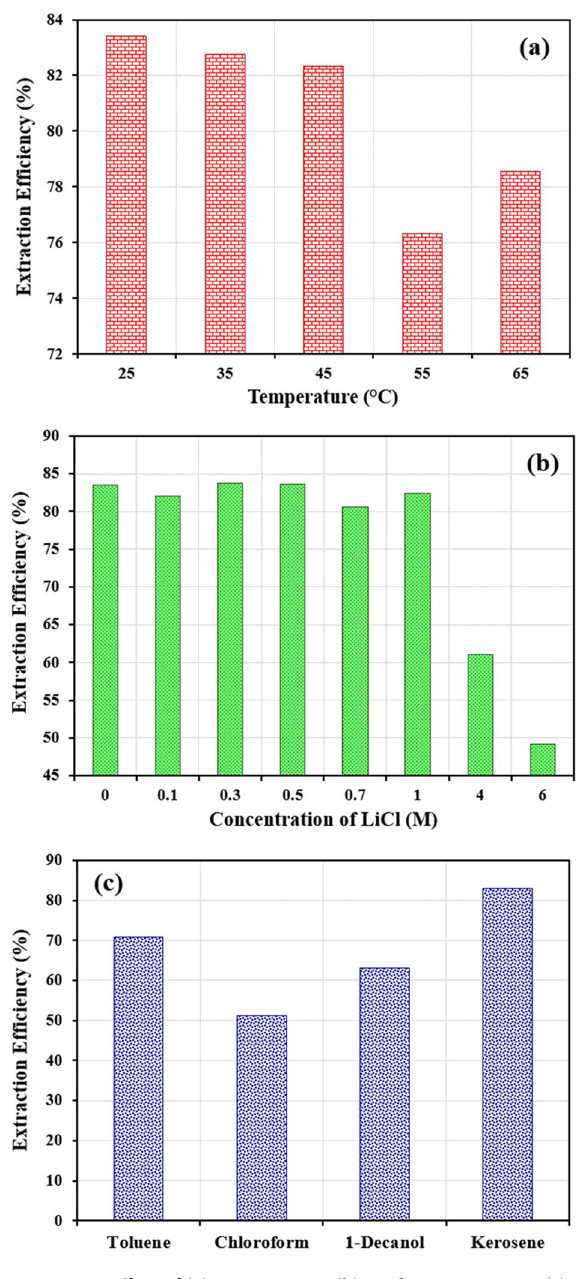
Figure 6. Effect of ( a ) temperature; ( b ) LiCl concentration; ( c ) type of solvent on cobalt extraction efficiency under optimum condition (80% EG; 0.05 M Cyanex301; time = 10 min; Co(II) = 800 ppm; pH =